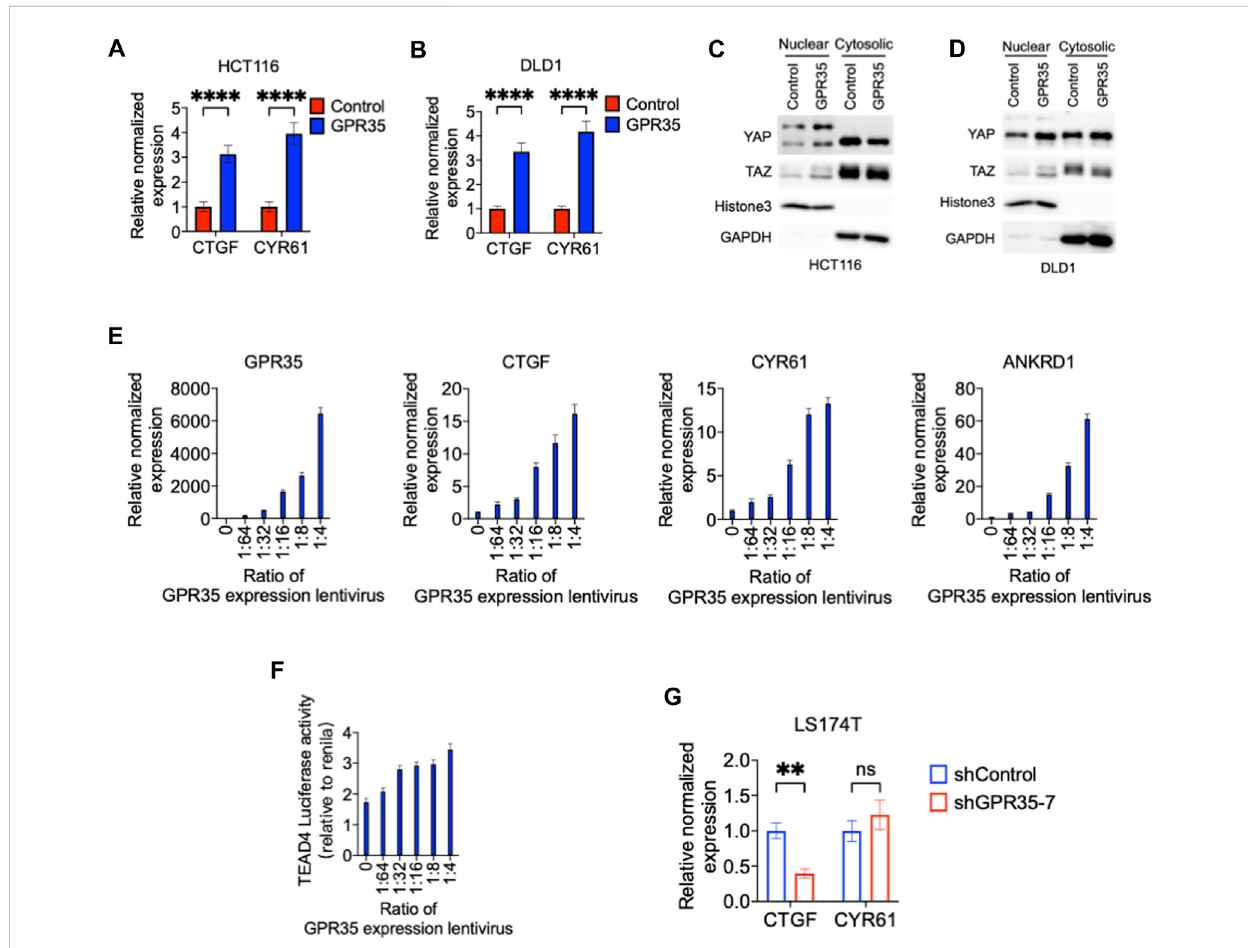
FIGURE 3 GPR35 expression enhanced YAP/TAZ activity. (A,B) Normalized mRNA expression of CTGF and CYR61 in established cell lines relative to parental control cell lines; (C,D) Nuclear and cytoplasmic distribution of YAP and TAZ analyzed by Western blot; (E) The normalized mRNA expression level of GPR35relativetonon-infected293FTcells;andNormalizedmRNAexpressionofCTGF,CYR61,andANKRD1;CellswereinfectedwithGPR35expression lentivirusatthedifferentratiosandharvestedforreal-timePCRassayafter48 hofincubation. (F) Dual-luciferasereporterassayonTEAD4luciferase activity relative to Renilla luciferase activity. Cells harvest for the assay after 48 h of incubation with different concentrations of GPR35 expression lentivirus. (G) Normalized mRNA expression level of CTGF and CYR61 relative to shControl